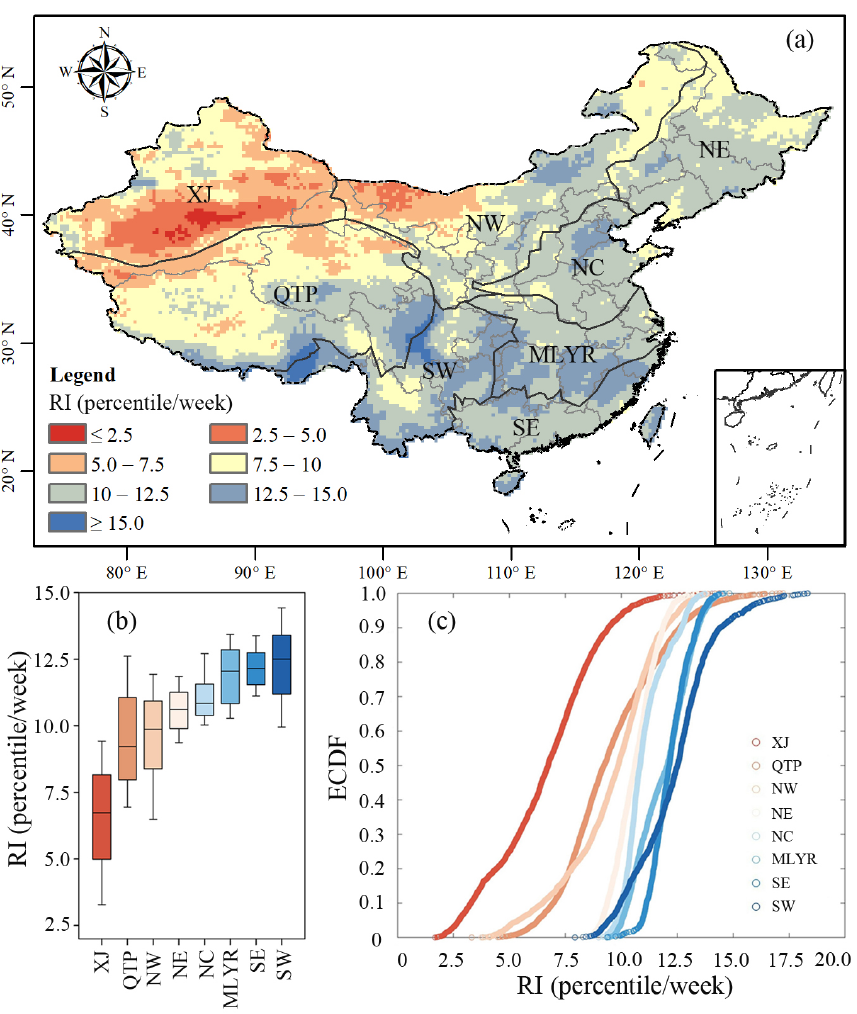
Figure 3. (a) Spatial distribution of the average rate of intensification (RI) during 1979–2016. (b) Box plots of the average RI and (c) empirical cumulative probability distribution function (ECDF) of the average RI over different sub-regions in the study area. The sub-regions are Northeast China (NE), Northern China (NC), the middle and lower reaches of the Yangtze River region (MLYR), Southeastern China (SE), Northwestern China (NW), Southwestern China (SW), Qinghai–Tibet Plateau (QTP), and Xinjiang